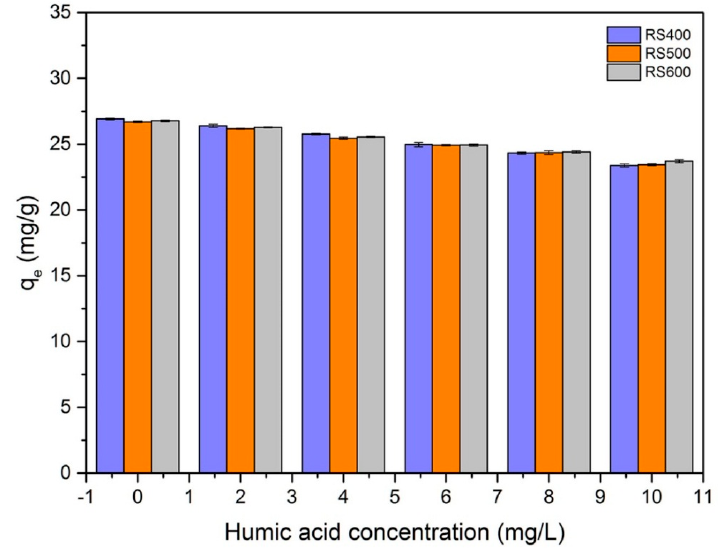
Figure 7. Effect of the humic acid (initial concentration = 6 mg L − 1 ; biochar dose = 0.01 g; temperature = 301